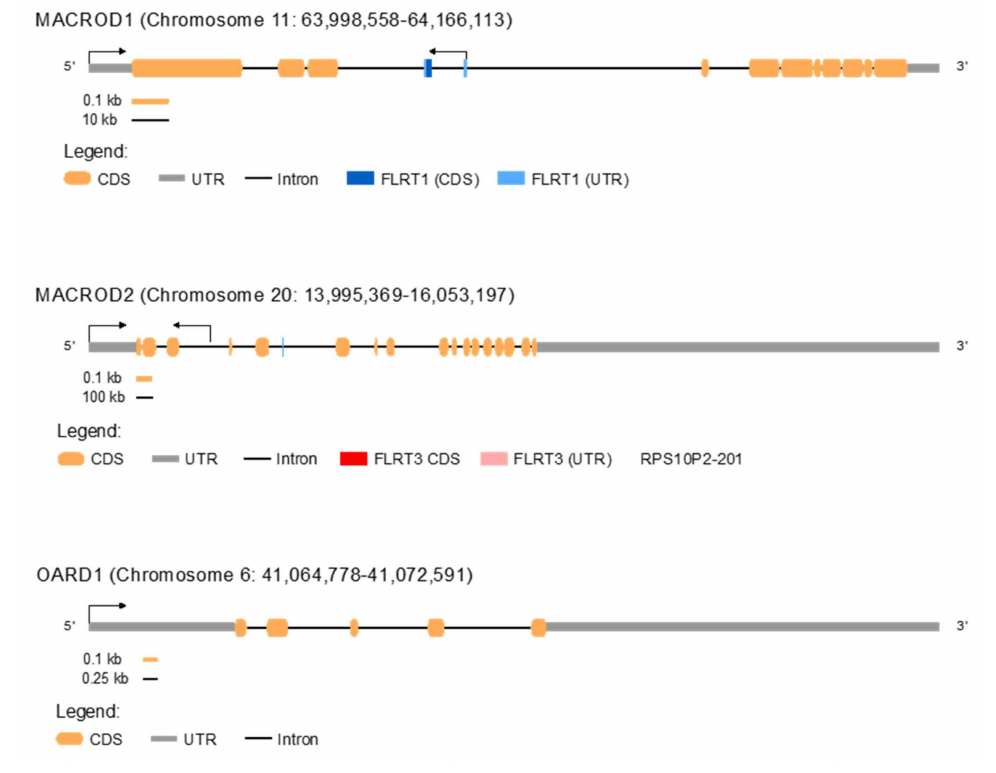
Figure 1. Overview of the MACROD1 , MACROD2 , and OARD1 gene